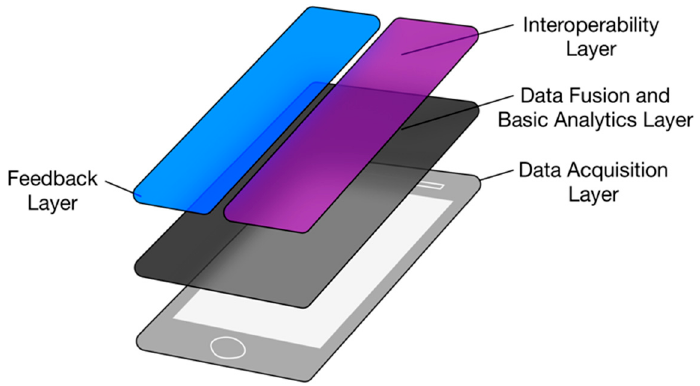
Figure 3. Distribution of the four layers that comprise the Edge node.